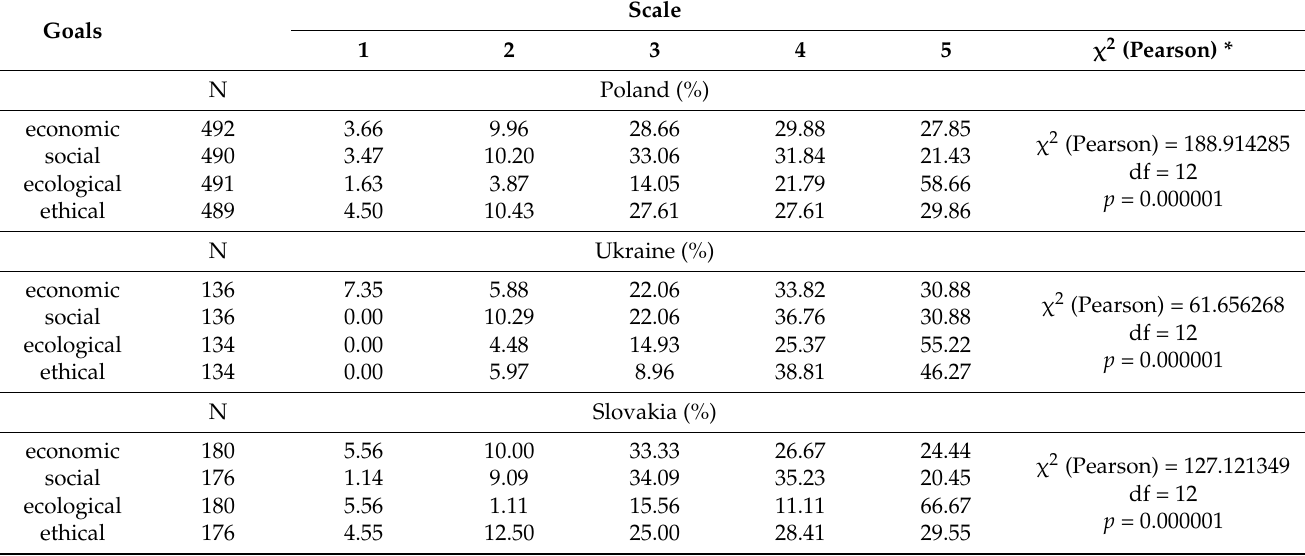
Table 8. Assessment of the fulfilment of economic, social, ecological and ethical goals by ZW concept in the opinion of respondents from Poland, Ukraine and Slovakia (scale of 1–5, where 1—does not meet this goal in general and 5—meets this goal very